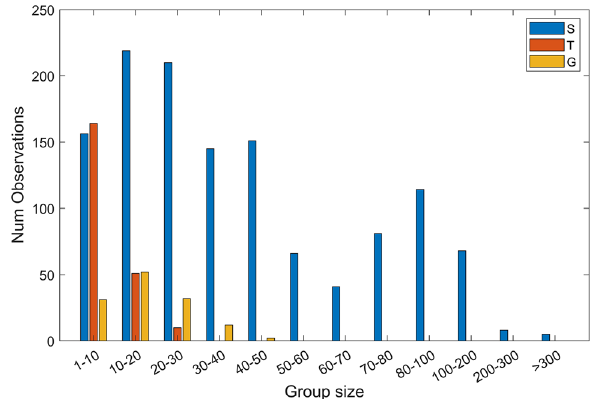
Figure 3. Distribution of the number of observations for different ranges of group sizes. The mark S refers to striped dolphin sightings, T to common bottlenose dolphin sightings and G refers to Risso’s dolphin sightings.